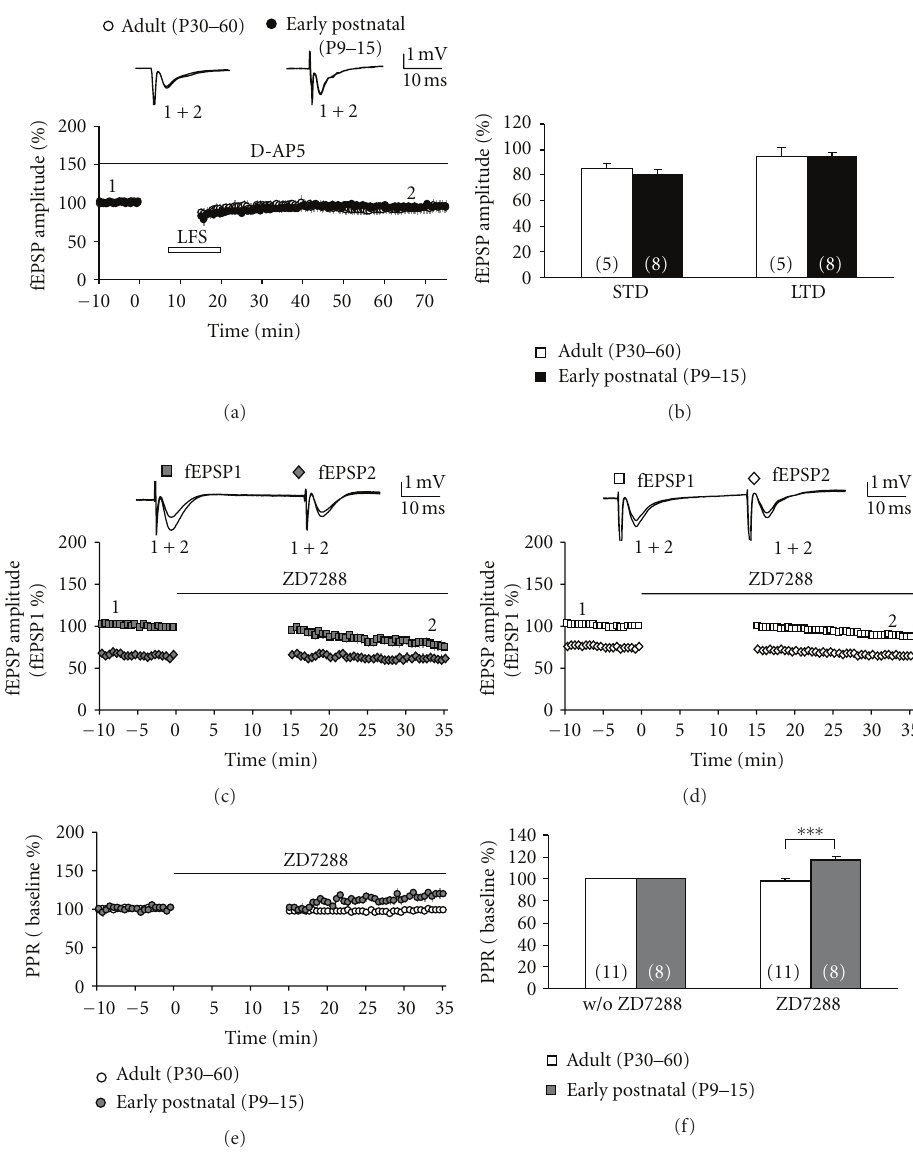
Figure 3: ZD7288 enhances the paired-pulse ratio in early postnatal, but not adult, rats. (a) The time course of the fEPSP amplitude following LFS in adult (P30–60, open symbols) and early postnatal rats (P9–15, closed symbols) shows no LTD in the presence of the NMDA receptor blocker D-AP5 (50 µ M, indicated by a black bar). Representative fEPSPs were taken at the beginning (indicated by “1”) and at the end (indicated by “2”) of the experiment. (b) The bar graph summarizes the STD and LTD levels in both adult (open bars) and early postnatal rats (closed bars) in the presence of D-AP5. (c) The time course of the fEPSP amplitudes (normalized to the fEPSP1 baseline) following paired-pulse stimulation (interpulse interval 40 ms) delivered to the MPP in early postnatal rats (P9–15) shows that ZD7288 (indicated by a black bar) depressed the first response (fEPSP1, gray boxes) more markedly than the second response (fEPSP2, gray diamonds). Representative fEPSPs were taken at the beginning (indicated by “1”) and at the end (indicated by “2”) of the experiment. (d) The time course of the fEPSP amplitudes (normalized to the fEPSP1 baseline) following paired-pulse stimulation (interpulse interval 40ms) delivered to the MPP in adult rats (P30–60) shows that ZD7288 (black bar) depressed the first (fEPSP1, open boxes) and the second response (fEPSP2, open diamonds) to the same degree. Representative fEPSPs were taken at the beginning (indicated by “1”) and at the end (indicated by “2”) of the experiment. (e) Time courses of the PPR (normalized to baseline PPR) in both age groups: adult (open symbols) and early postnatal rats (gray symbols). Note that ZD7288 increased PPR only in early postnatal animals. (f) The bar graph summarizes the normalized paired-pulse ratio of both age groups recorded before and after ZD7288 treatment. ZD7288 significantly increased the PPR in early postnatal, but not in adult, animals. All data are mean ±